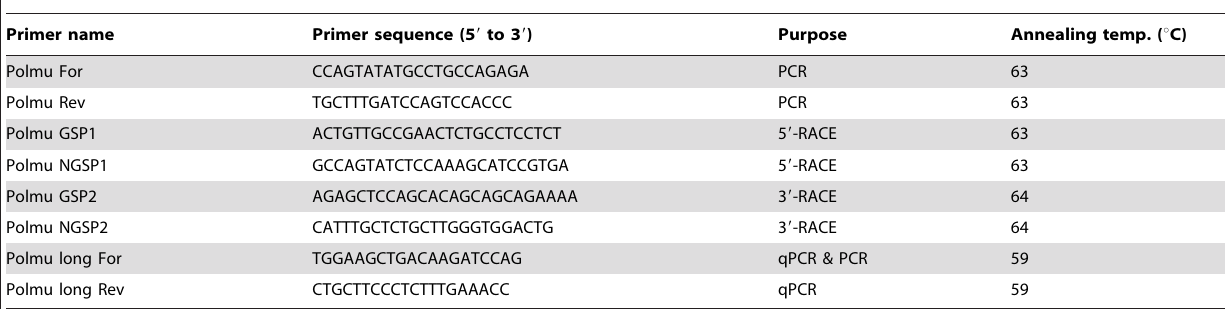
Table 1. Primers used in this